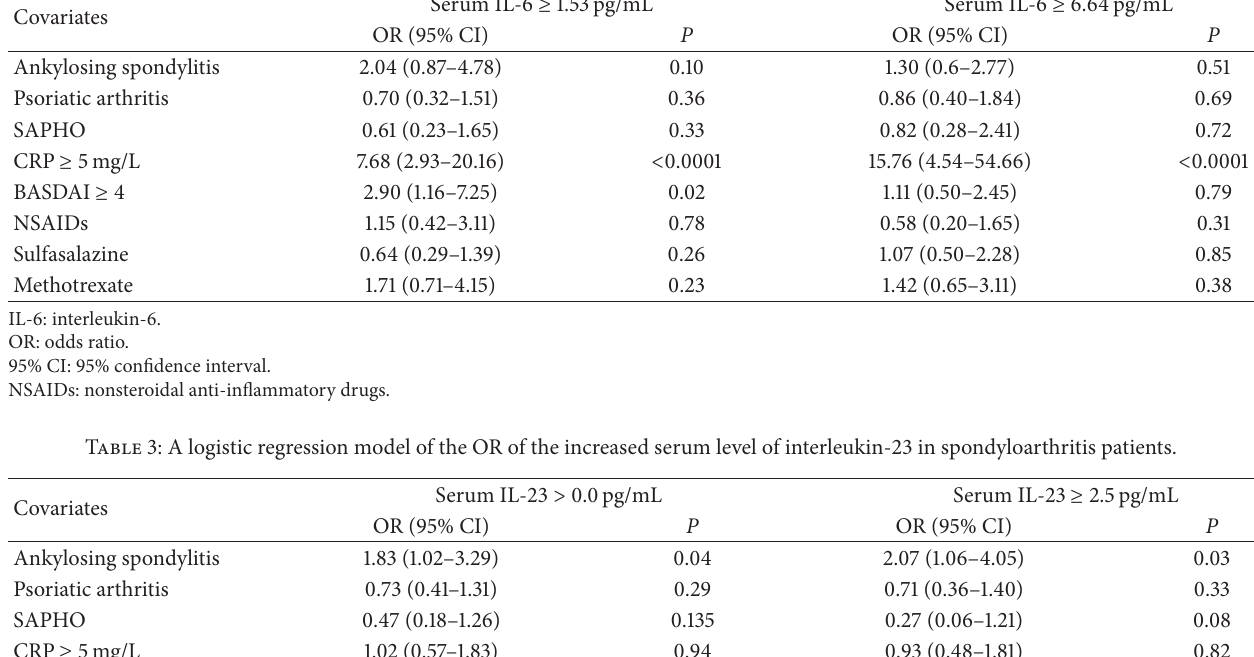
Table 2: A logistic regression model of the OR of the increased serum level of interleukin-6. Covariates